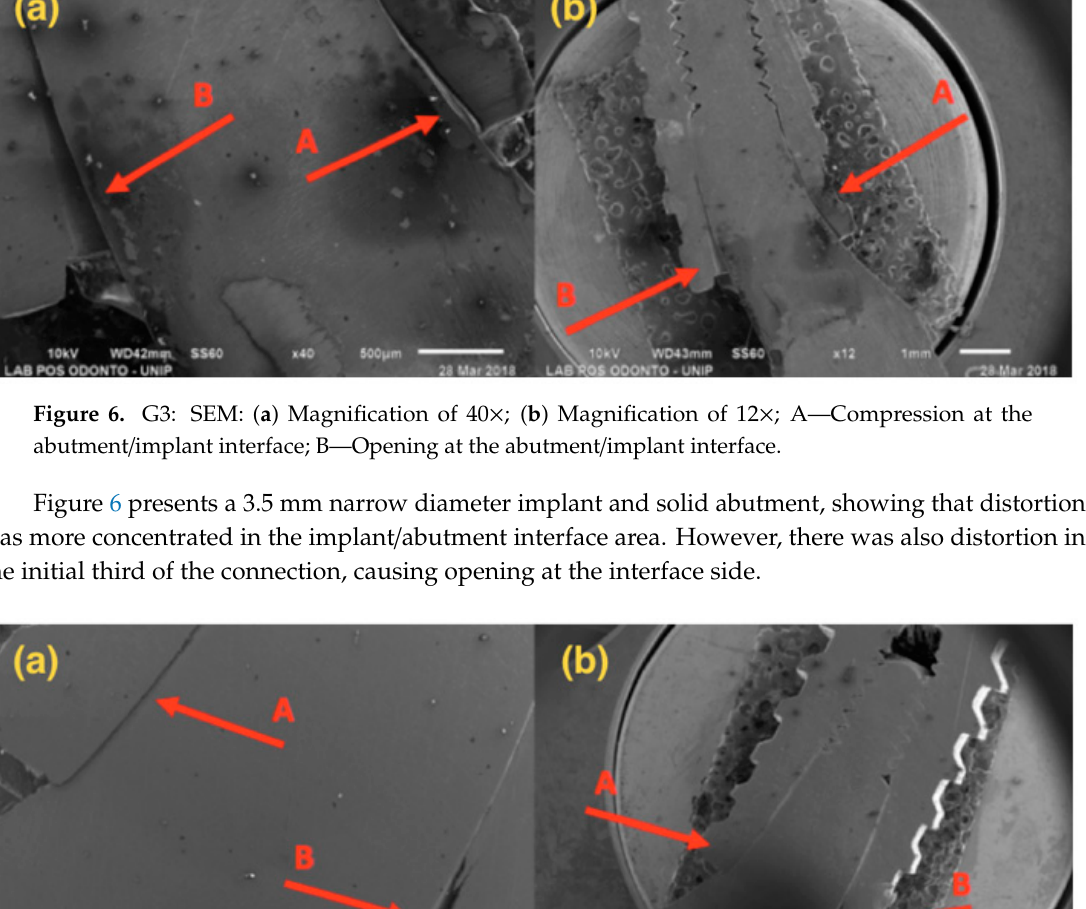
Figure 5. G2: Photomicrography: ( a ) Magnification of 12×; ( b ) Magnification of 45×; A—Distortion is seen in the region of the implant body.